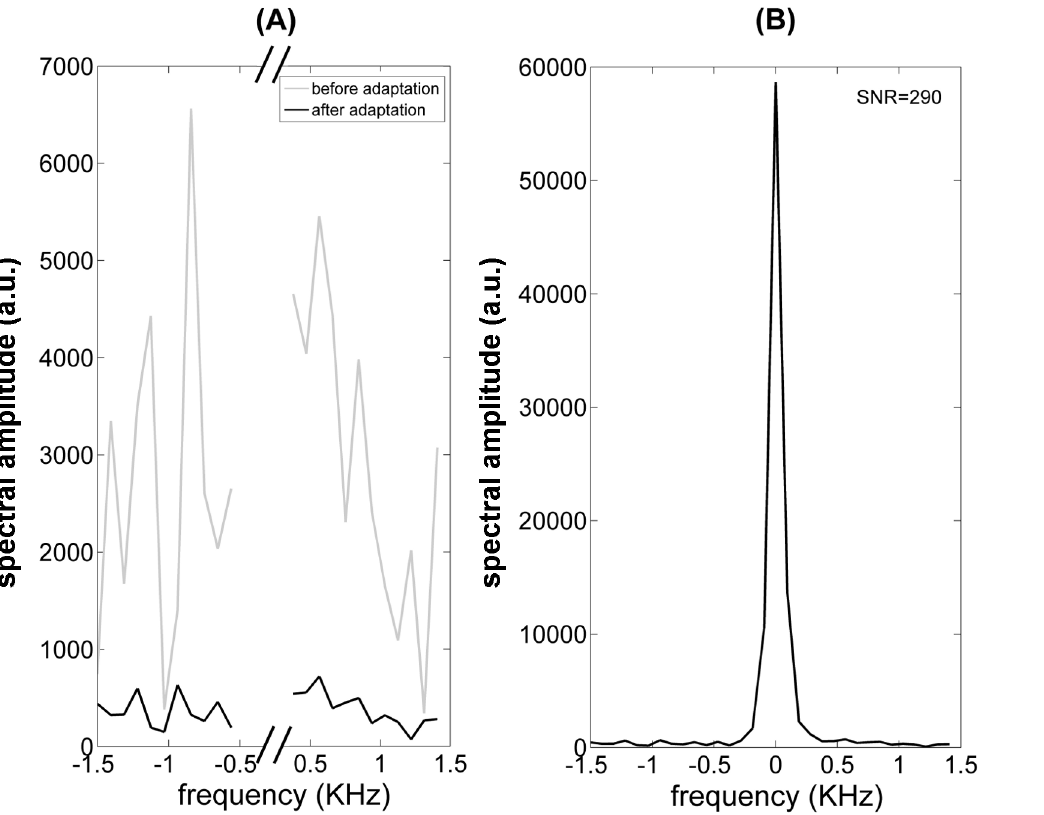
Fig 3. Spin echo recordings (T E = 19 ms, T R = 500, NEX = 10): (A) system noise before and after the improvements done in the integration of the MRI system with the MSR; (B) an echo recorded in the final configuration. The 10-fold noise reduction provides strong evidence of the care that has to be used in integrating a VLF-MRI device with a MSR designed for MEG